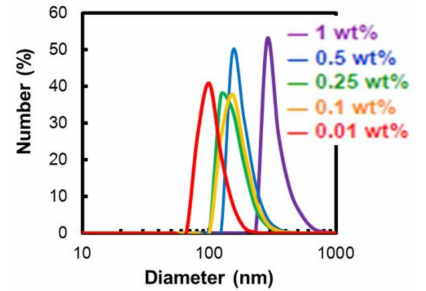
Figure 1. Effects of P 400 -OC 8 H 17 concentration on micelle size distribution.